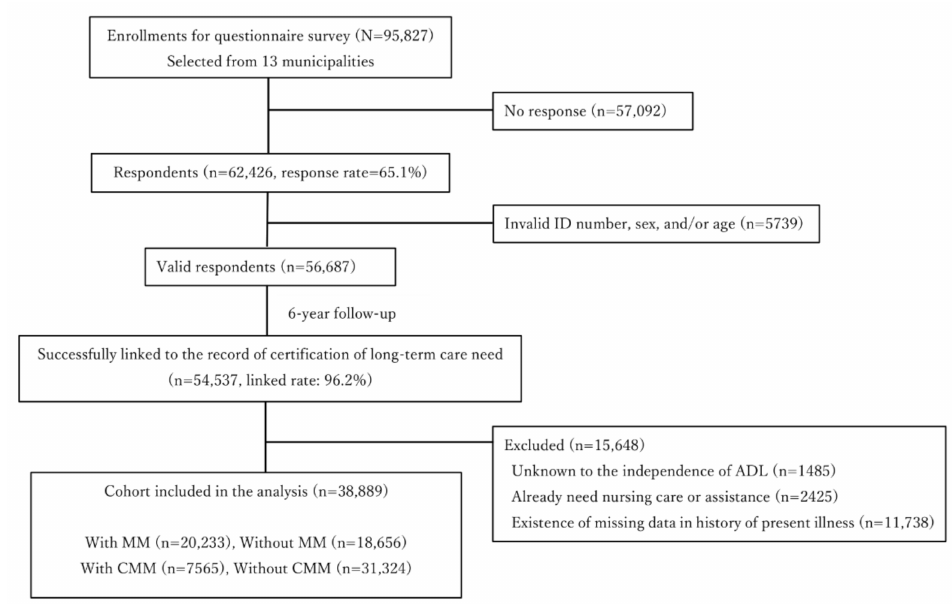
Figure 1. Study Population. Complex multimorbidity (CMM), multimorbidity